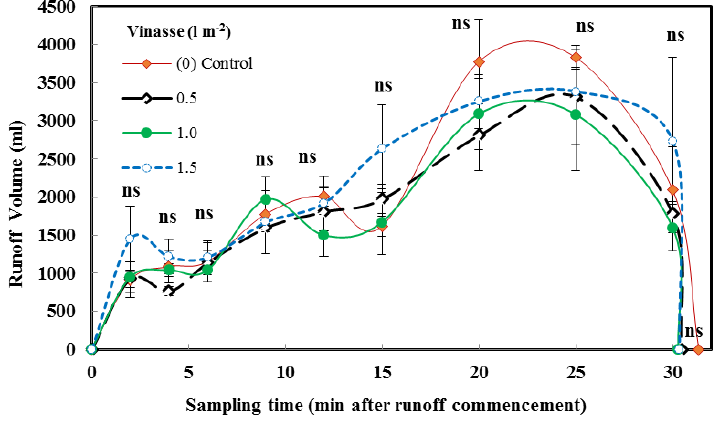
Figure 2. Variations of runoff volume per m 2 area under different vinasse treatments under study conditions (rainfall intensity of 72mmh − 1 and experiment duration of 30min); “ns” indicates non significant differences among study treatments ( P > 0.05) for each sampling time.